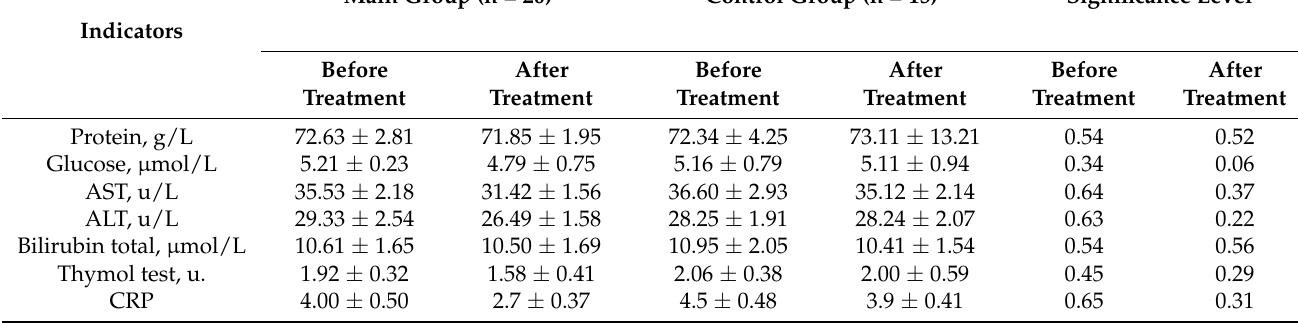
Table 4. Biochemical status of patients with peripheral atherosclerosis during treatment.